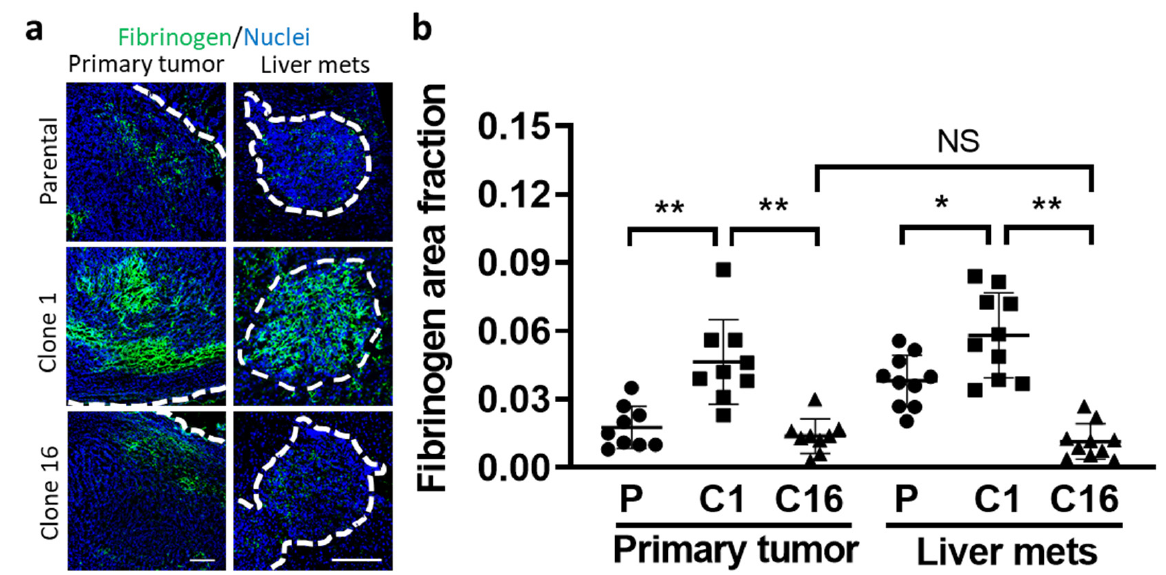
Figure 4. Tumor cell type and organ-dependent difference in coagulation. The amount of fibrinogen indicative of coagulation in tumors (surrounded by white dotted lines) was evaluated by immunohistochemical staining of the tissue sections and imaging using confocal microscopy ( a ). The area fraction of fibrinogen inside the tumors was compared between clones at two tumor sites ( b ). (* p < 0.05; ** p < 0.001; NS: no significant difference.) Scale bar, 100 µm.